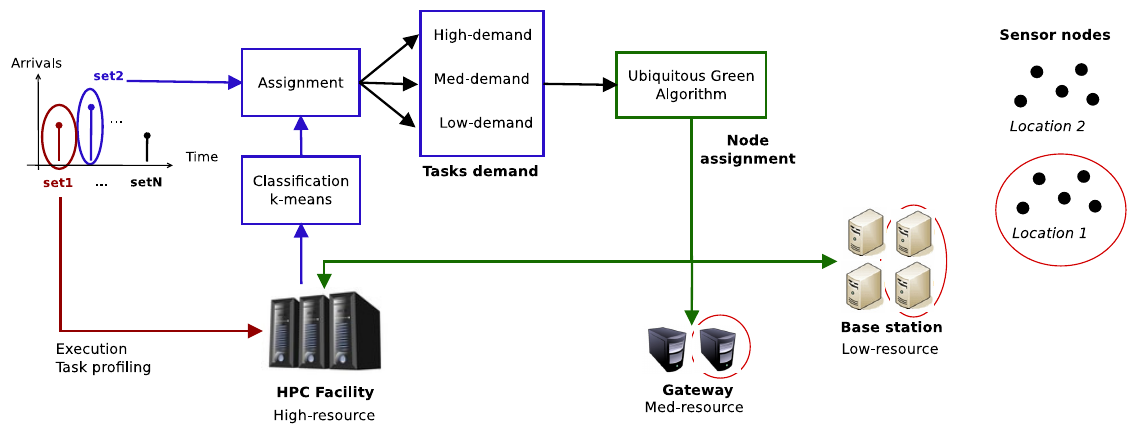
Figure 5. Energy Optimization